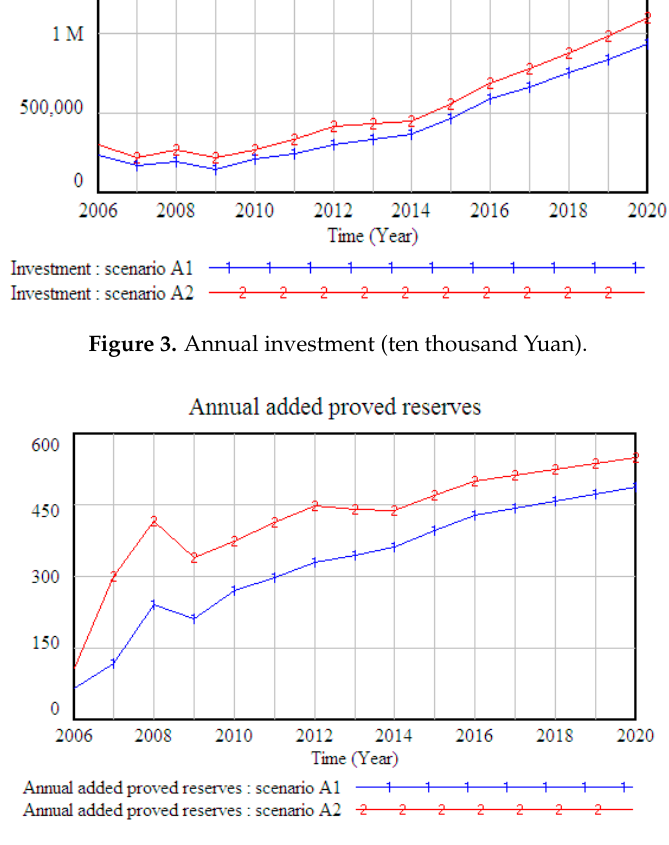
Figure 4. Annual added proved reserves (billion cubic meters). Energies 2017 , 10 , x FOR PEER REVIEW